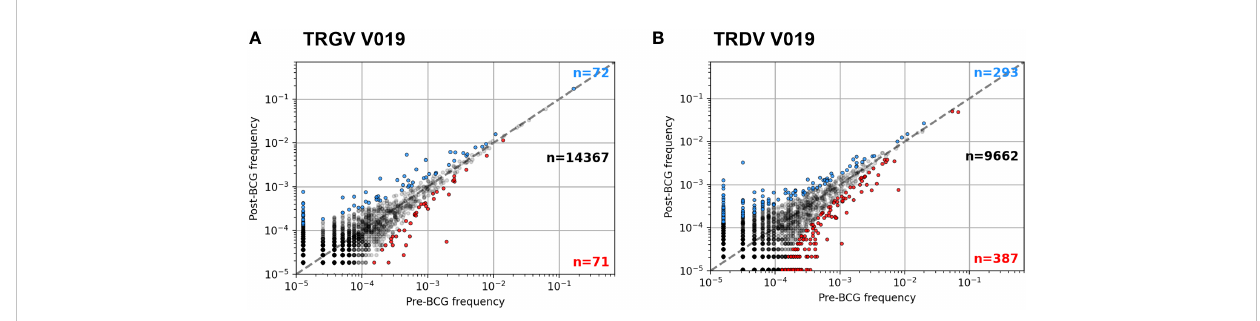
FIGURE 4 Example frequency scatter plots of per participant clonotype analysis. Pre- and Post-BCG TCR g (A) and TCR d (B) repertoires were analyzed from each participant. Figure shows example frequency scatter plots for one participant (V019); analysis of additional participants provided in the Supplementary Materials. Each symbol represents one TCR single chain clonotype plotted as pre vs. post BCG frequency. Symbols colored blue (red) show clonotypes with an FDR-adjusted q-value < 0.05 indicating a signi fi cant increase (decrease) in frequency after BCG vaccination (Fisher ’ s exact test). For plotting, a pseudocount of one was added to the observed counts of each TCR; as a result, the data at the lowest frequency represents TCRs that were not observed in the respective sample (pre- or